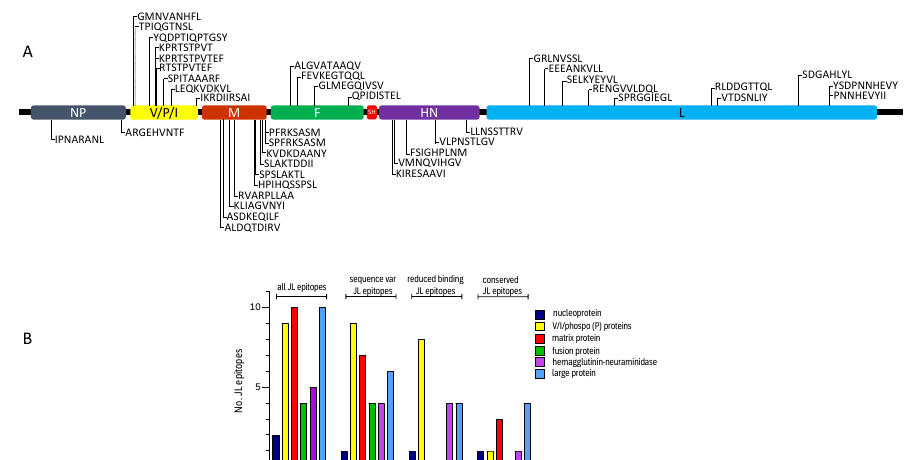
Figure 1. Characteristics of identified CD8 + T cell epitope candidates of Jeryl–Lynn (JL) vaccine mumps virus (MuV). Location of the JL vaccine MuV epitope candidates within the MuV proteins ( A ). Distribution of JL vaccine MuV candidate epitopes among the various MuV proteins. No epitope candidates of small hydrophobic (SH) protein (57 amino acids long) were identified ( B ). Number of total JL vaccine MuV candidate epitopes among the various MuV proteins are presented, as well as number of JL vaccine MuV candidate epitopes that show to have sequence differences in circulating MuV strains, number of JL vaccine MuV candidate epitopes that show to have sequence differences in circulating MuV strains that led to reduced predicted binding to one or more human leukocyte antigen Class I molecules, and number of JL vaccine MuV candidate epitopes with conserved amino acid sequences, i.e., epitopes that show no sequence differences in any of the circulating MuV strains. NP, nucleoprotein; V/P/I, V/phospo (P)/I proteins; M, matrix protein; F, fusion protein; SH, small hydrophobic protein; HN, hemagglutinin-neuraminidase; L, large